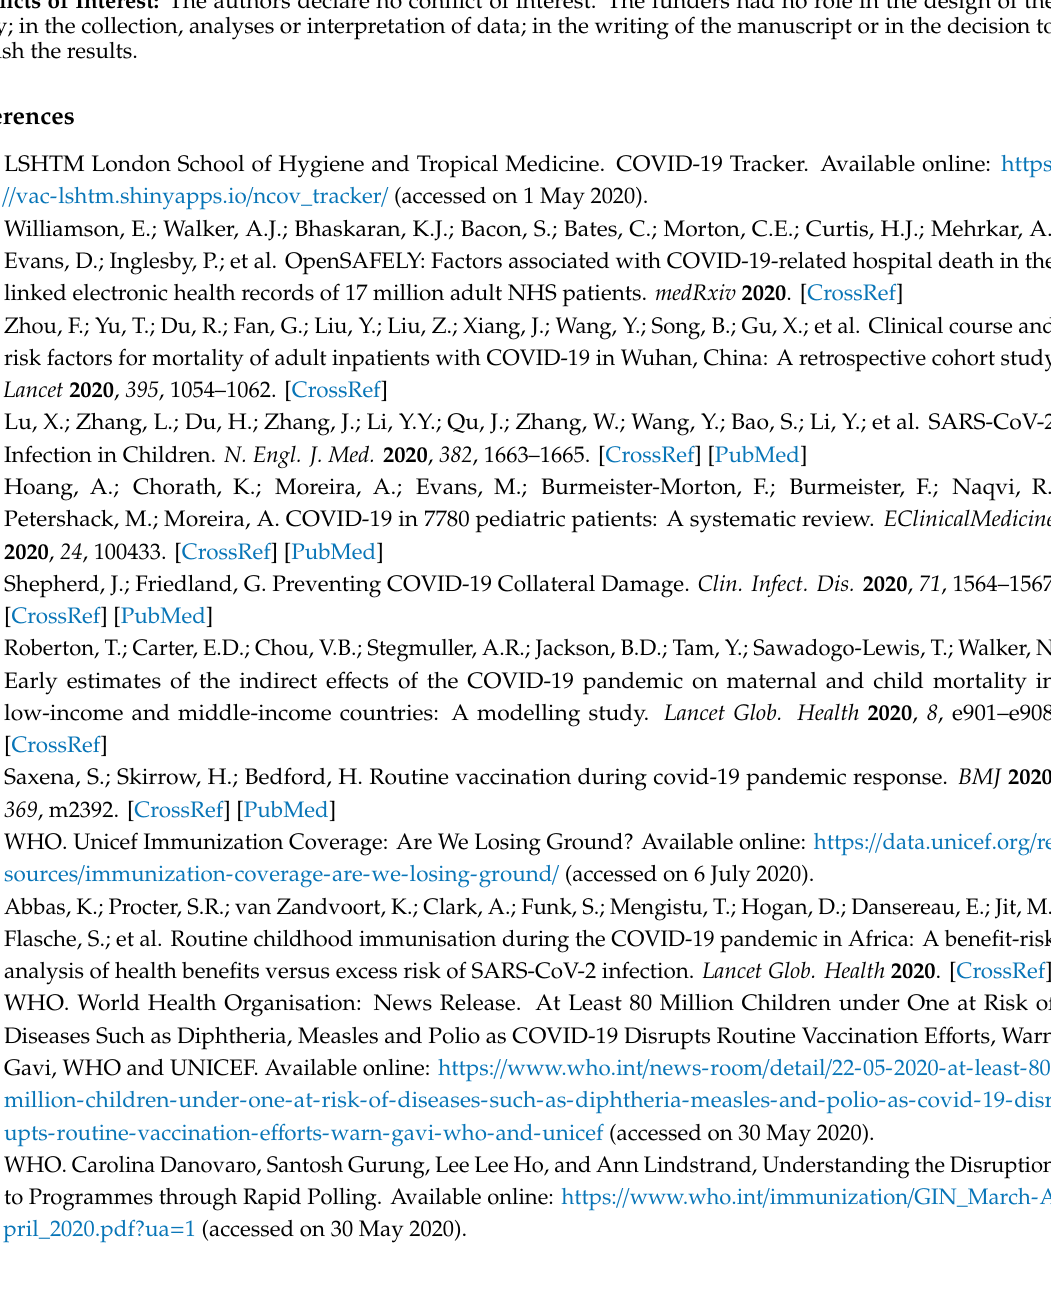
Table S1: Region, country of origin and occupation of respondents, and Questionnaire to IMPRINT